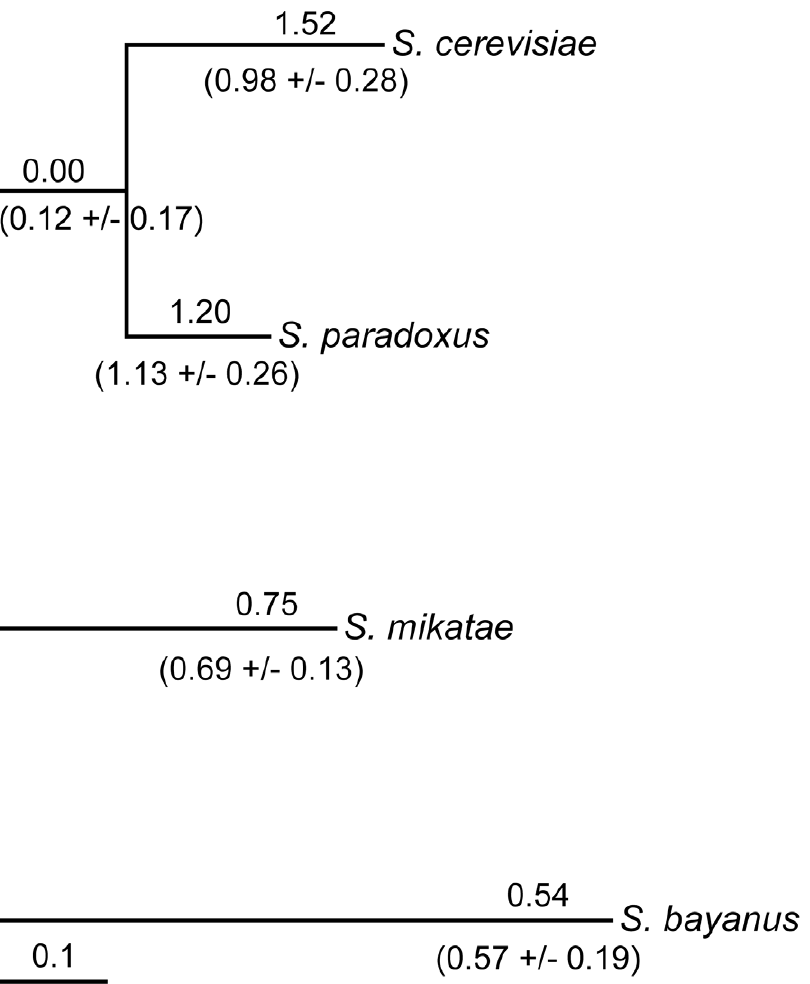
Figure 1. Variation in noncoding substitution rates upstream of FZF1 . The ratio of the noncoding substitution rate upstream of FZF1 relative to genome-wide substitution rates at fourfold degenerate sites, dNC/dS, is shown above each lineage for the original alignment. The mean and standard deviation of dNC/dS from 18 different alignments (Table S1) is shown below each lineage. dNC/dS was estimated for each lineage using an unconstrained model by maximum likelihood methods implemented in HyPhy. The tree is scaled to the fourfold synonymous substitution